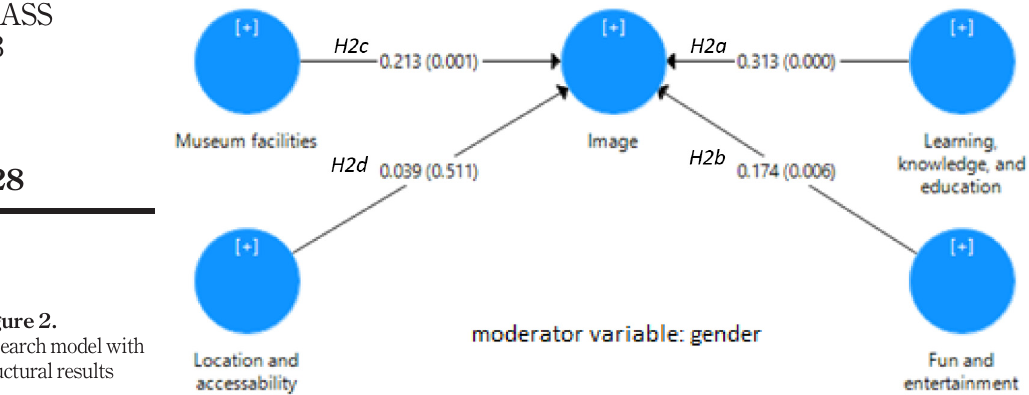
Figure 2. Research model with structural